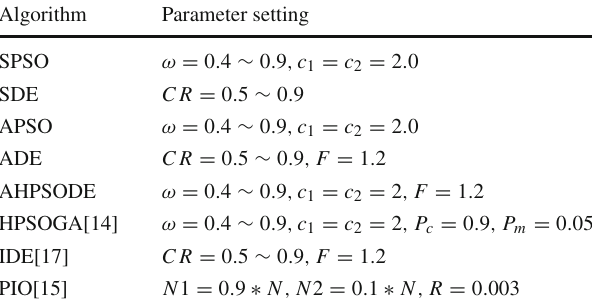
Fig. 10 The optimal task assignment result of 10 UAVs in 3D